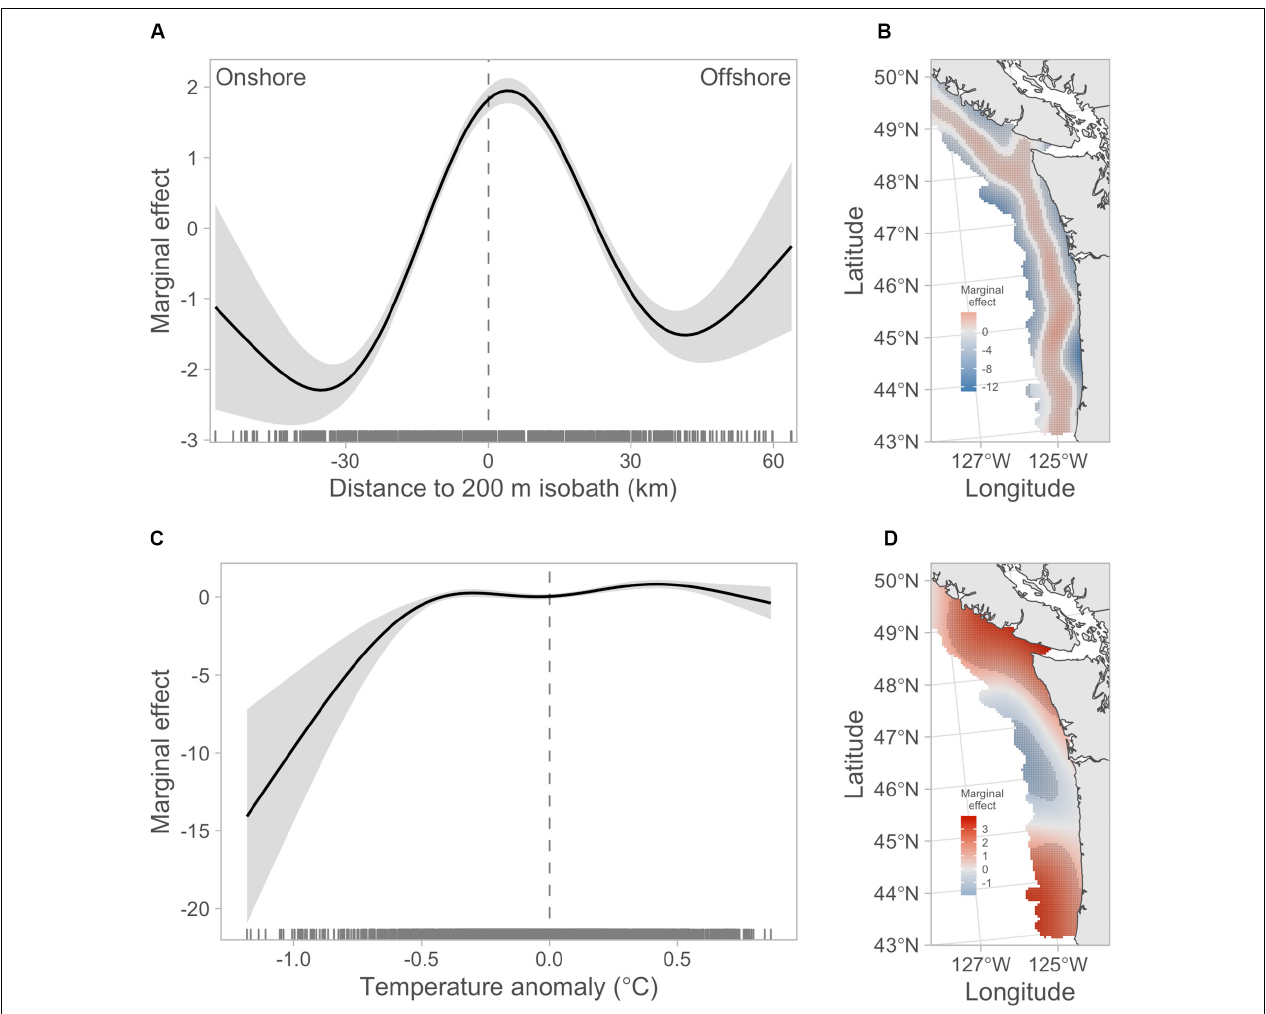
FIGURE 2 | Marginal effects of covariate smooths from the GAMs. (A) Marginal effect of shelf break term in model GAM2. (B) Marginal effect of bivariate longitude–latitude term in model GAM1. (C) Marginal effect of stationary temperature anomaly term in model GAM3. (D) Marginal effect of spatially non-stationary temperature anomaly term in model GAM4. In panels (A,C) , gray shaded regions show 95% confidence intervals. In panels (B,D) , stippling indicates location where the 95% confidence interval for the covariate effect does not include zero.